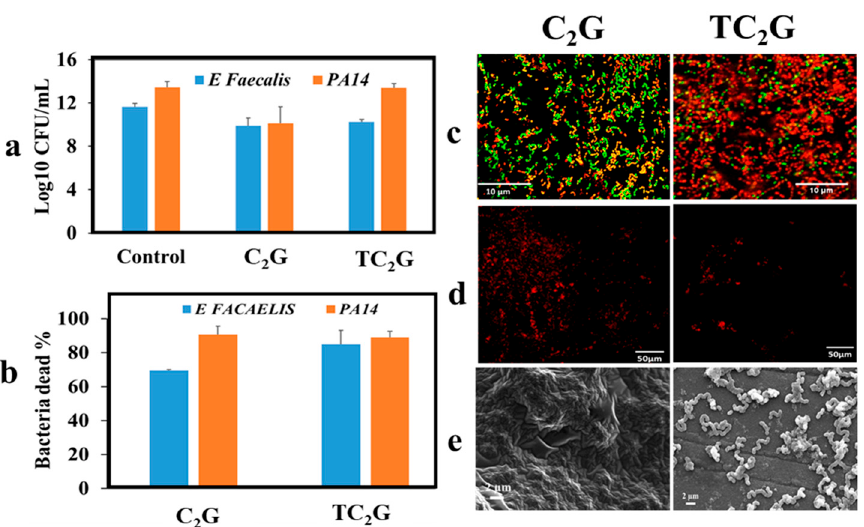
Figure 8. ( a ) Antimicrobial activity of hydrogels. Log 10 reduction of bacteria (mean log CFU/mL of x experiments) after 24 h incubation on hydrogel and CFU plating. The control represented only bacteria without incubation on hydrogel. ( b ) quantitative data of the effect of hybrid hydrogels on the viability of bacteria stained with LIVE/DEAD ® Bacterial Viability Kit showing more >70% of bacteria dead after incubation with the hydrogels for 24 h. ( c ) Representative confocal microscopy images of bacteria on the surface of hydrogels after 24 h incubation period. Fluorescence images showing live (green) and dead (red) bacteria. ( d ) Fluorescence images (Live/dead stain) showing bacteria are dead in the hydrogels after 24 h. ( e ) SEM micrographs of bacteria attached to the surface of C 2 G hydrogels and not attached on the surface TC 2 G hydrogels at 24 h.